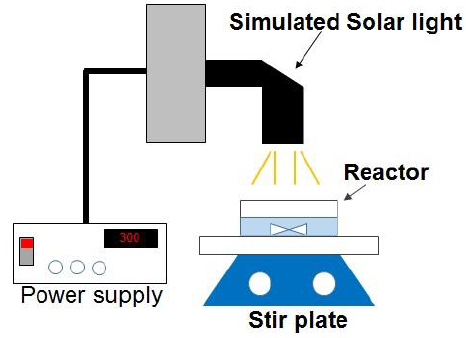
Figure 8. A schematic diagram of the photocatalytic experimental procedure.